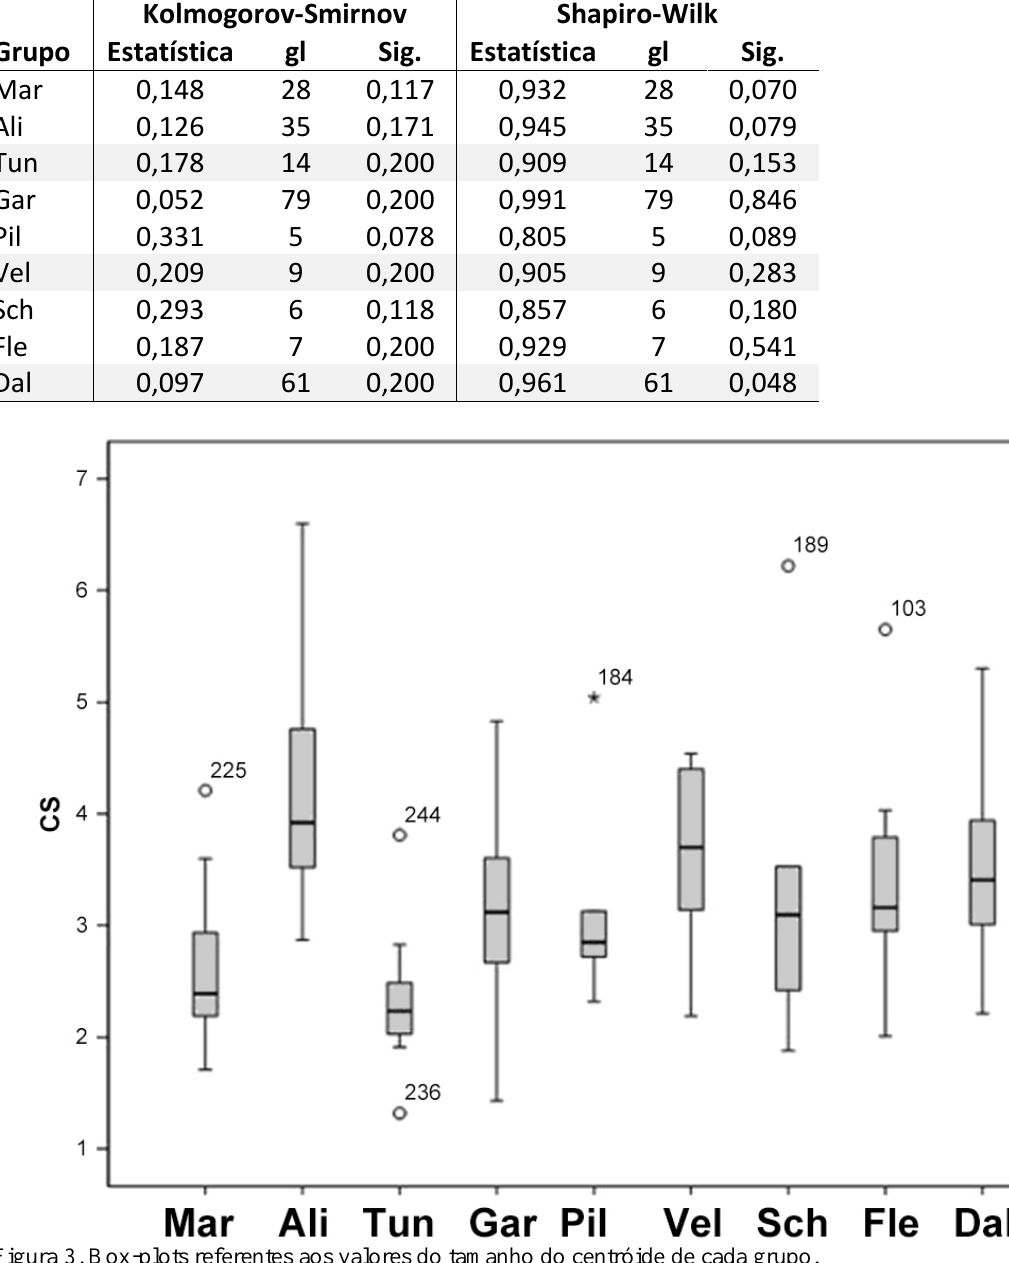
Figura 3. Box-plots referentes aos valores do tamanho do centróide de cada grupo. Figure 3. Box-plots referring to the centroid size values of each group.